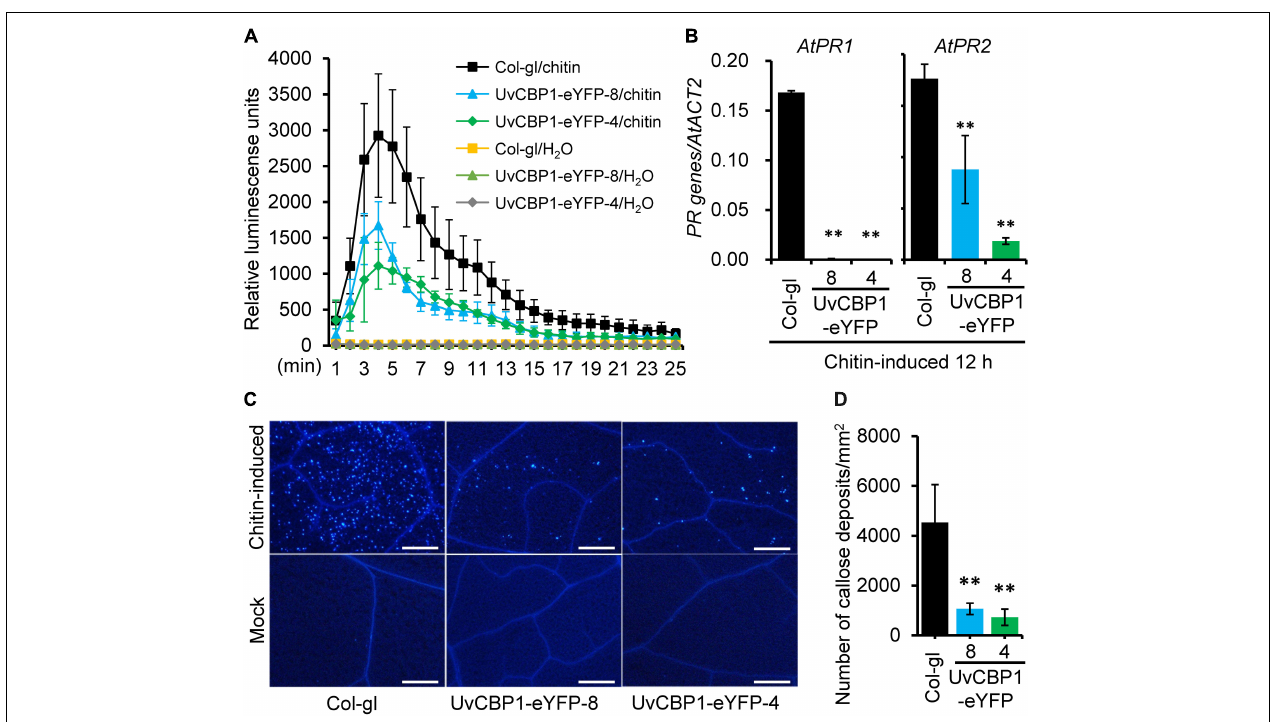
FIGURE 3 | UvCBP1 suppresses chitin-triggered immunity in Arabidopsis thaliana. (A) Chitin-induced burst of ROS. Data were represented as the mean ± SD of four biological replicates. (B) Expression analysis of defense-related genes in chitin-treated leaves of UvCBP1 -expressing plants and Col-gl control. Relative expression levels of indicated genes were determined using AtACT2 as the reference gene. Data were represented as the mean ± SD of three replicates. (C,D) Chitin-induced callose deposition. Leaves of indicated Arabidopsis plants were infiltrated with chitin. At 10 h post infiltration, leaves were collected for aniline blue staining. Representative microscopy images were shown (C) and the number of callose deposits was recorded (D) . Bar data were mean ± SD of four biological replicates. Scale bar, 50 µ m. Asterisk in this figure indicates significant difference determined by Student’s t test ( ∗∗ P < 0.01).